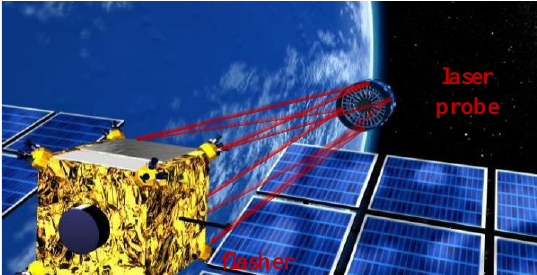
Figure 4. Diagram of the virtual telescope, XEUS.